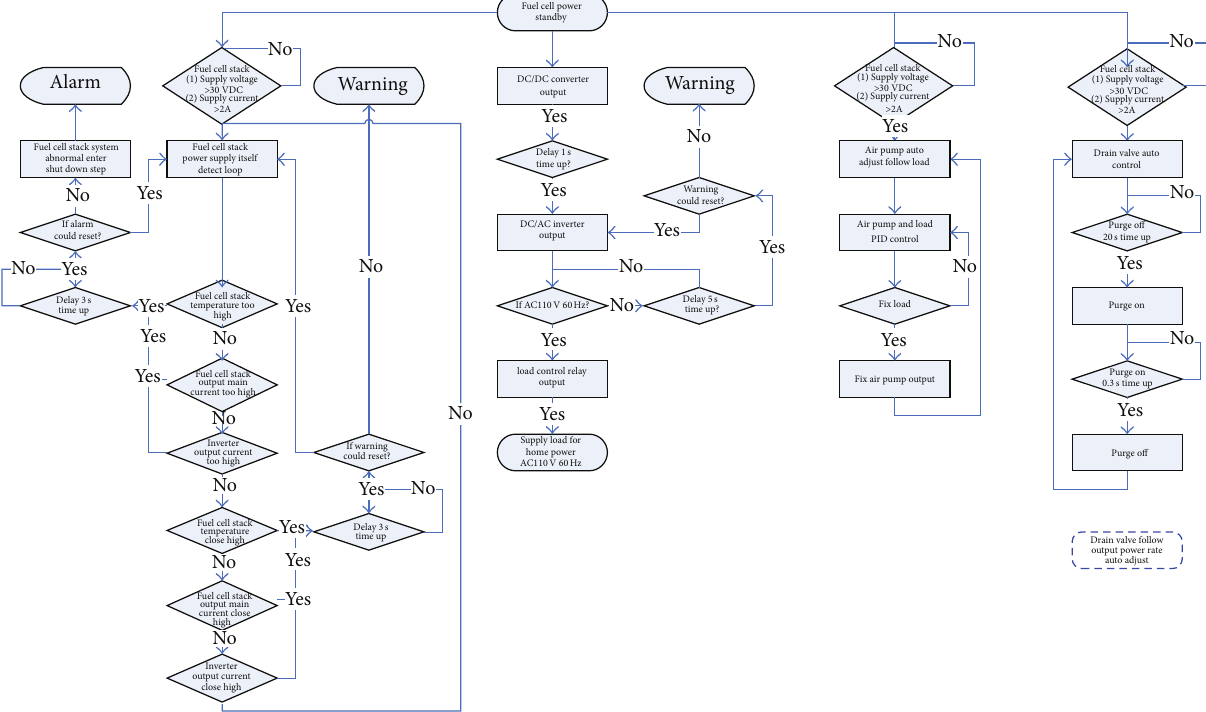
Figure 6: Operational flow of 8051 control system during long-term operation phase.